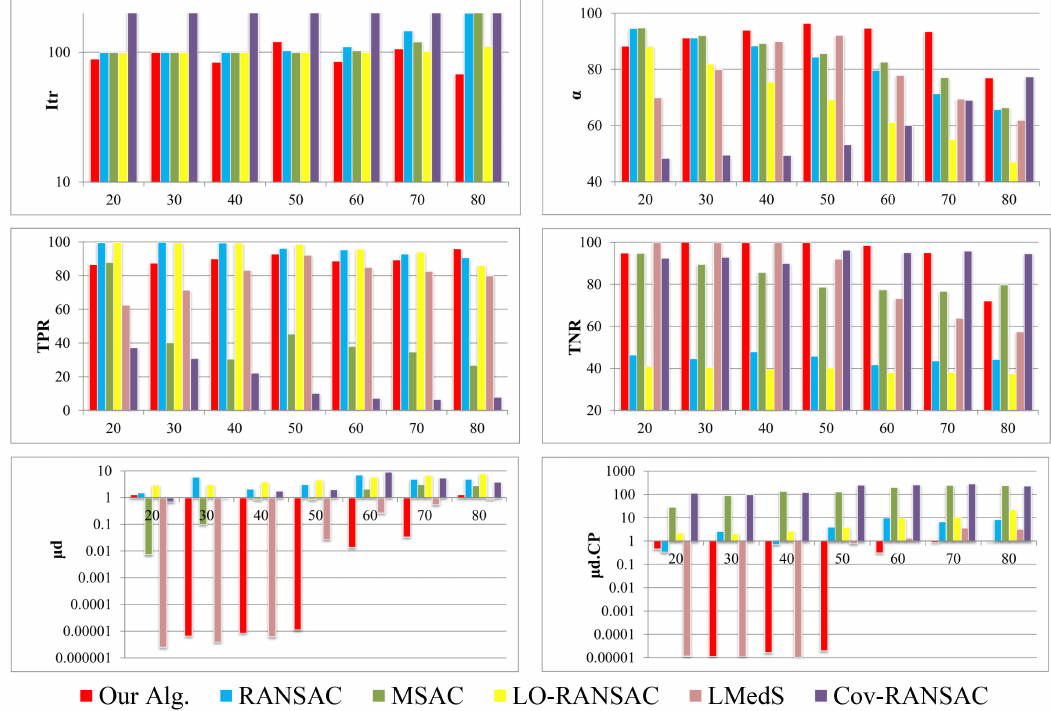
Figure 8. Performance of different algorithms under various percentages of outliers for the Multiview dataset. In the graphs, the x-axis represents the percentage of synthetic outliers in the